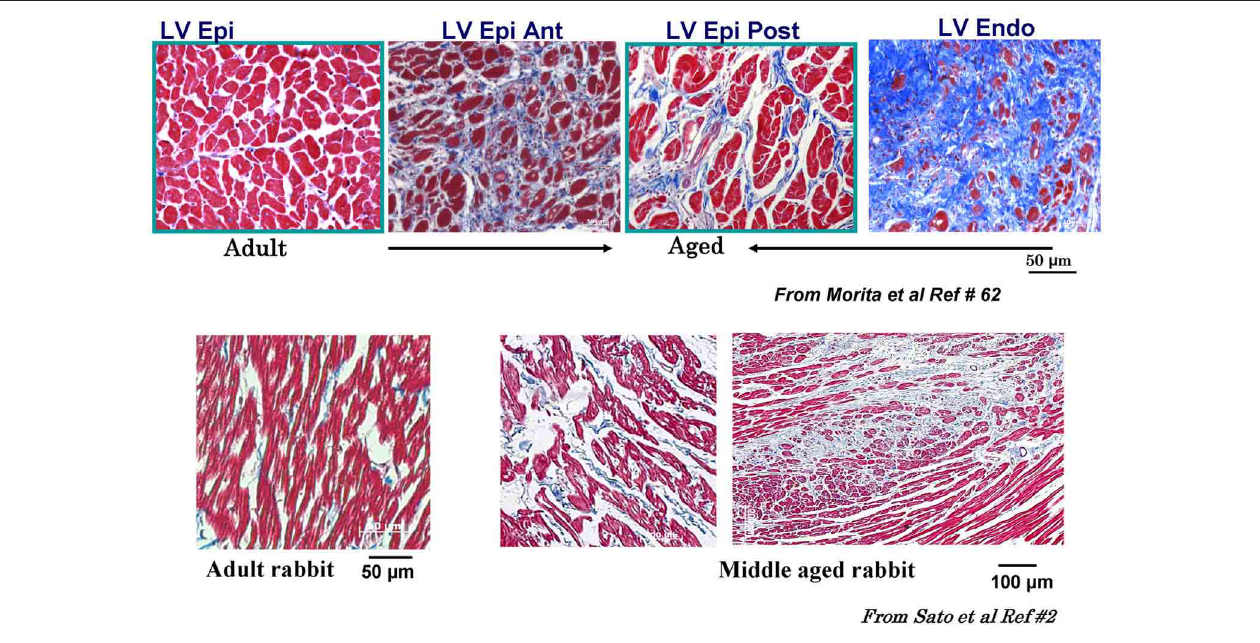
(LV) and the septum (blue color). Lower panels show LV fibrosis in the middle aged compared to adult rabbit LV. Ant, anterior; RV, right ventricle; Post, posterior; Epi, epicardium [from Sato et al., 2009 and Morita et al., 2009 (Lokuta et al.,